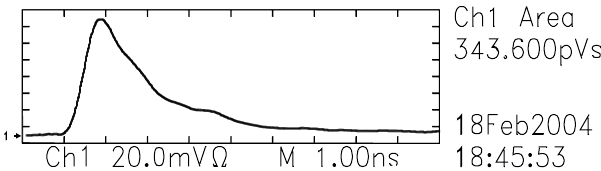
FIG. 6. Filters break the spectrum of wakefield radiation into five channels. The solid line is the theoretical emitted spectrum from a single bunch having rms length of 4.2 psec and charge 310